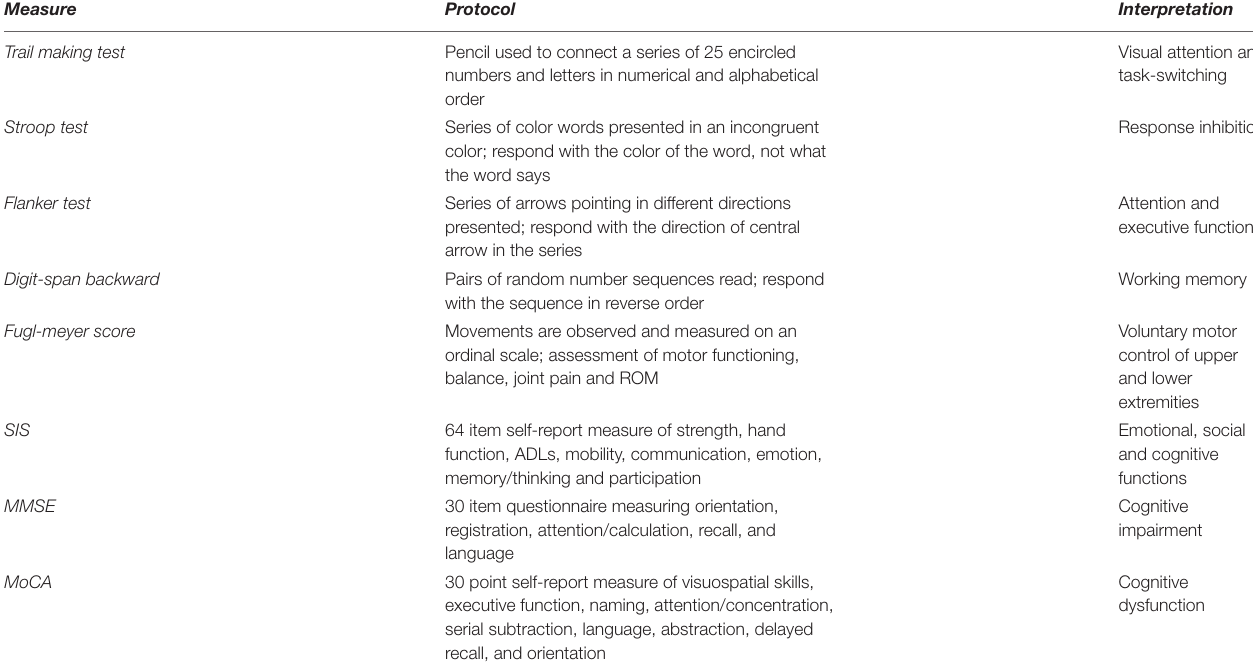
TABLE 2 | Cognitive assessments of